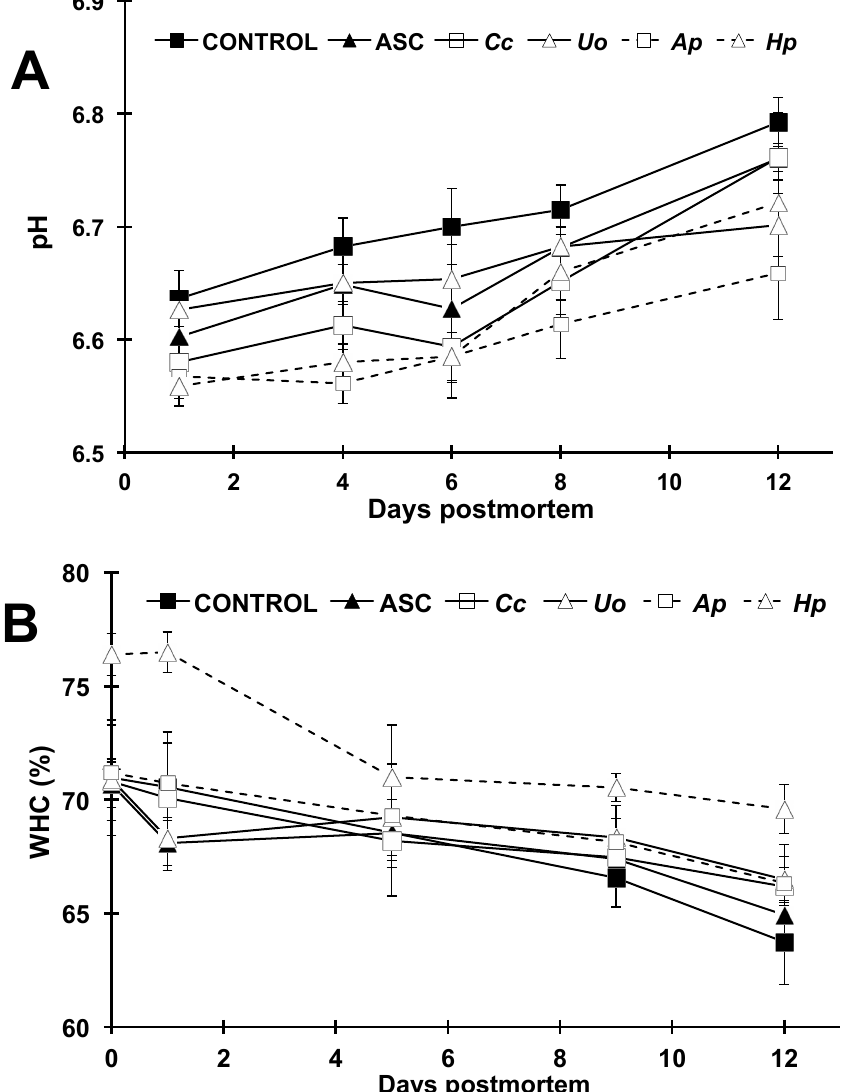
Figure 3. Postmortem changes in pH ( A ) and water holding capacity (WHC; B ) of rainbow trout fillets treated with distilled water (CONTROL); ascorbic acid (ASC) and aqueous extracts of Crassiphycus corneus ( Cc ), Ulva ohnoi ( Uo ), Arthrospira platensis ( Ap ) and Haematococcus pluvialis ( Hp ) during a 12-day cold storage (4 °C) period. Values are expressed as mean ± sd.